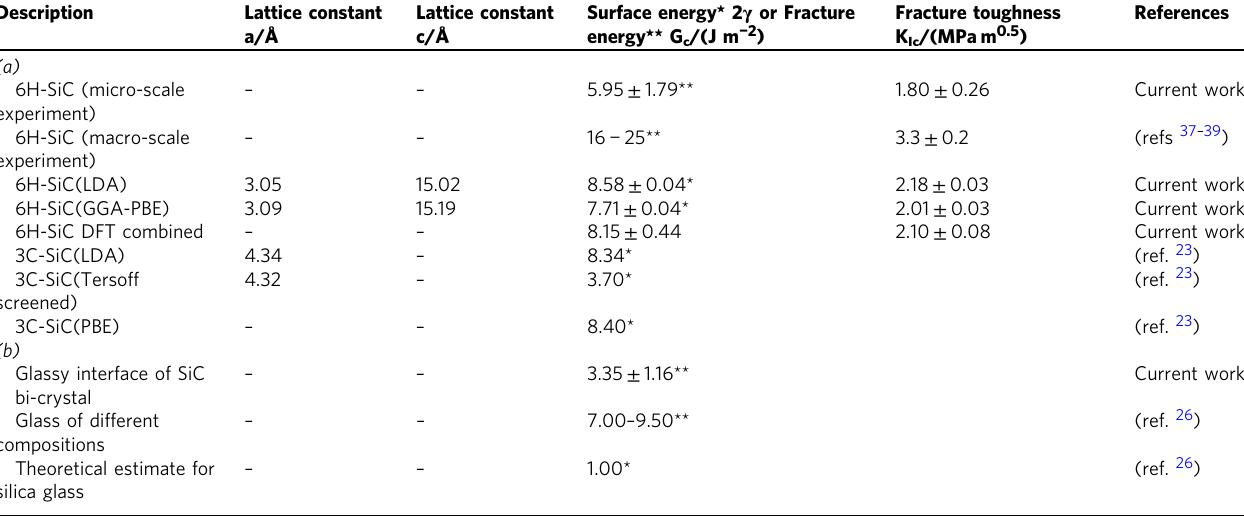
Table 1 Comparison between experimental and simulated fracture/surface energy values of SiC and glass